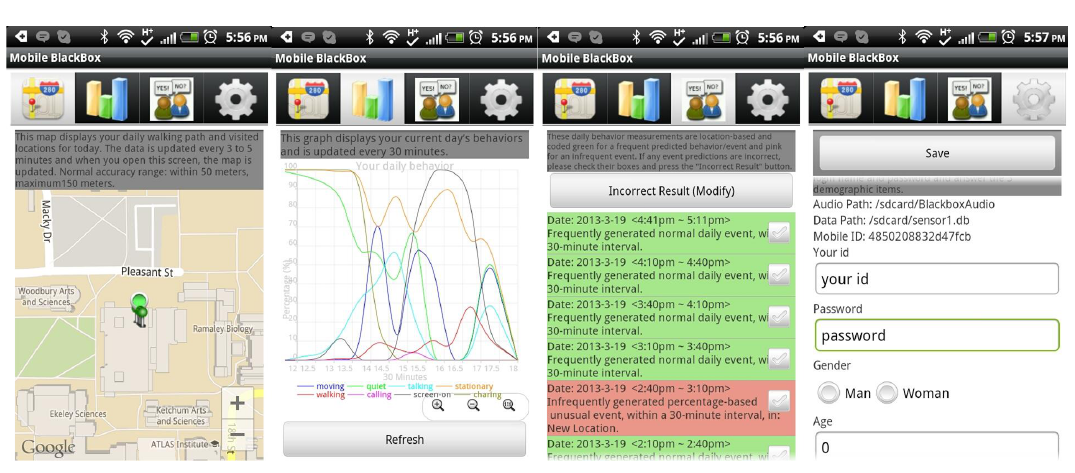
Figure 6. Screen shot of the myBlackBox